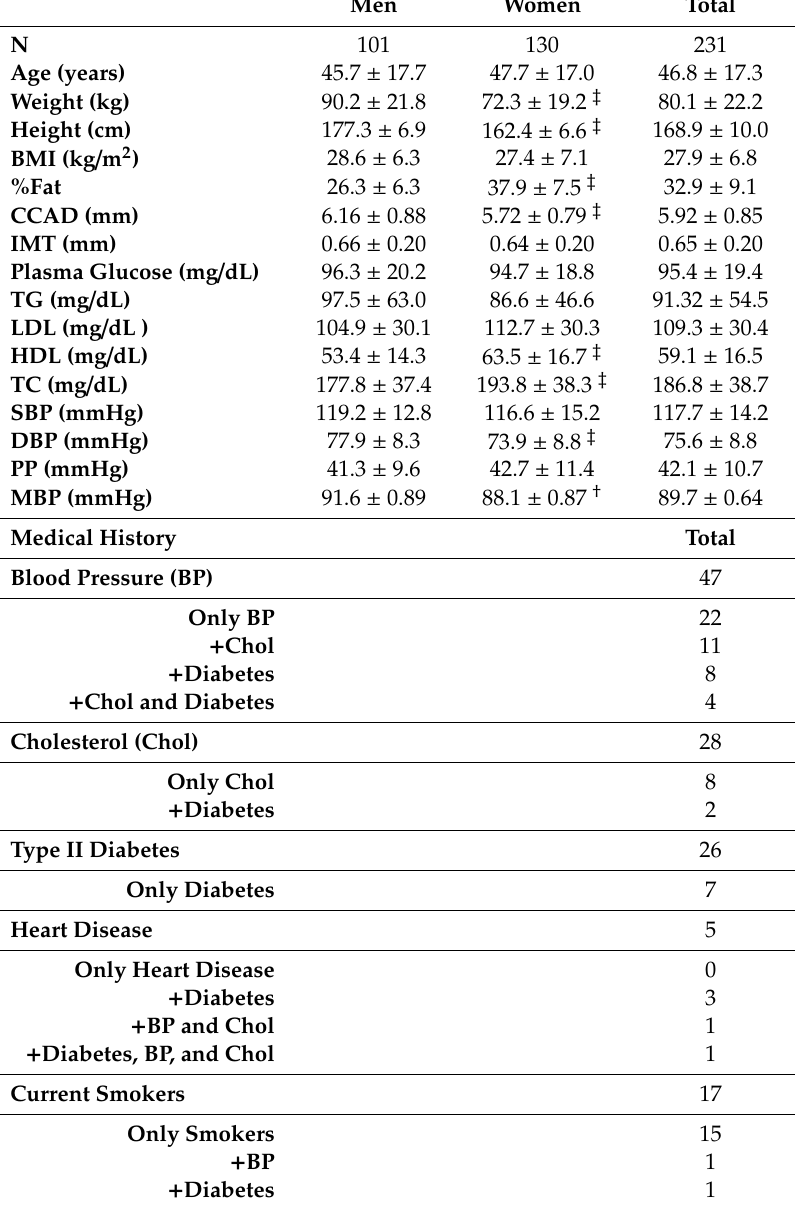
Table 1. Subject